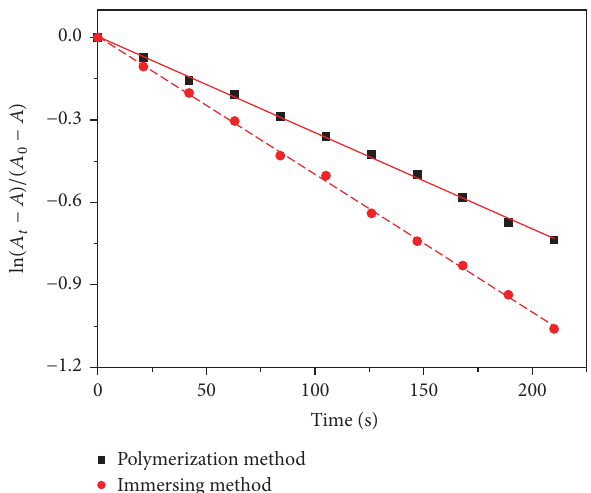
Figure 5: The thermal relaxation of the MC at 𝜆 max (620 nm, immersing method; 610 nm, polymerization method) after irradiation with a 40 W UV lamp.